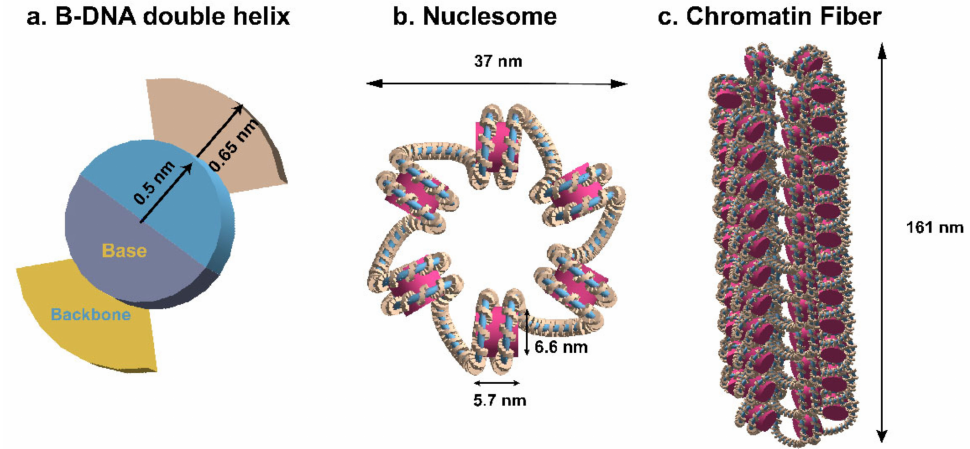
Figure 8. Solenoid chromatin fiber model constructed with Geant4 toolkit. ( a ) Structure of B-DNA double helix. ( b ) Model of six nucleosomes. ( c ) Chromatin fiber